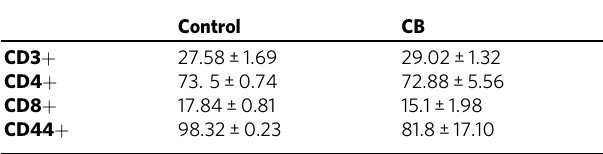
Table 1 FACS analysis showing numbers in immune cells isolated